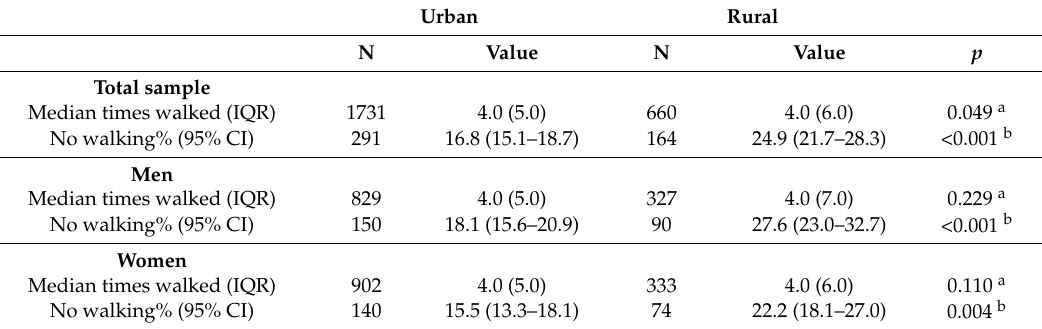
Table 2. Number of times walked (for at least 10 min) per week and proportion of participants who report doing no walking by area of residence and sex. Urban Rural N Value N Value